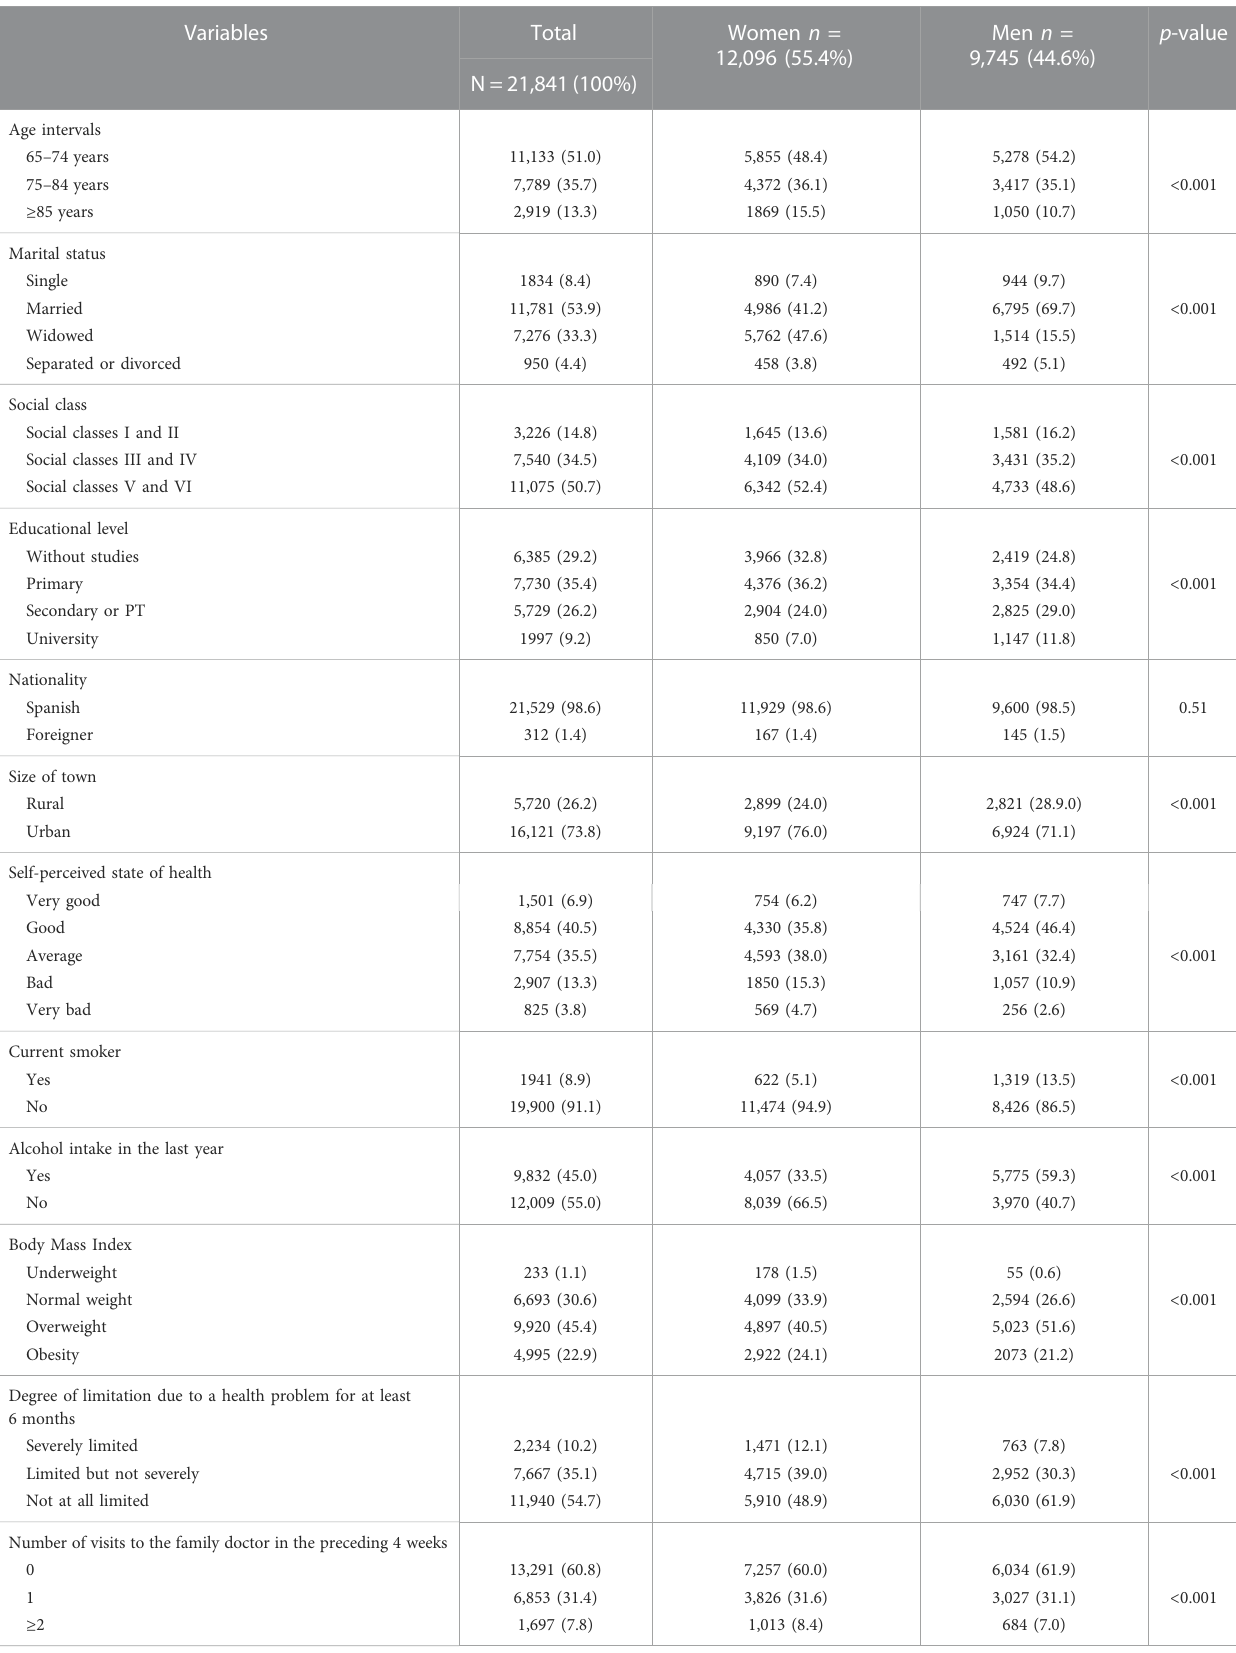
TABLE 1 Comparison of women and men as regards sociodemographic, health-related variables and use of clinical care services (N =